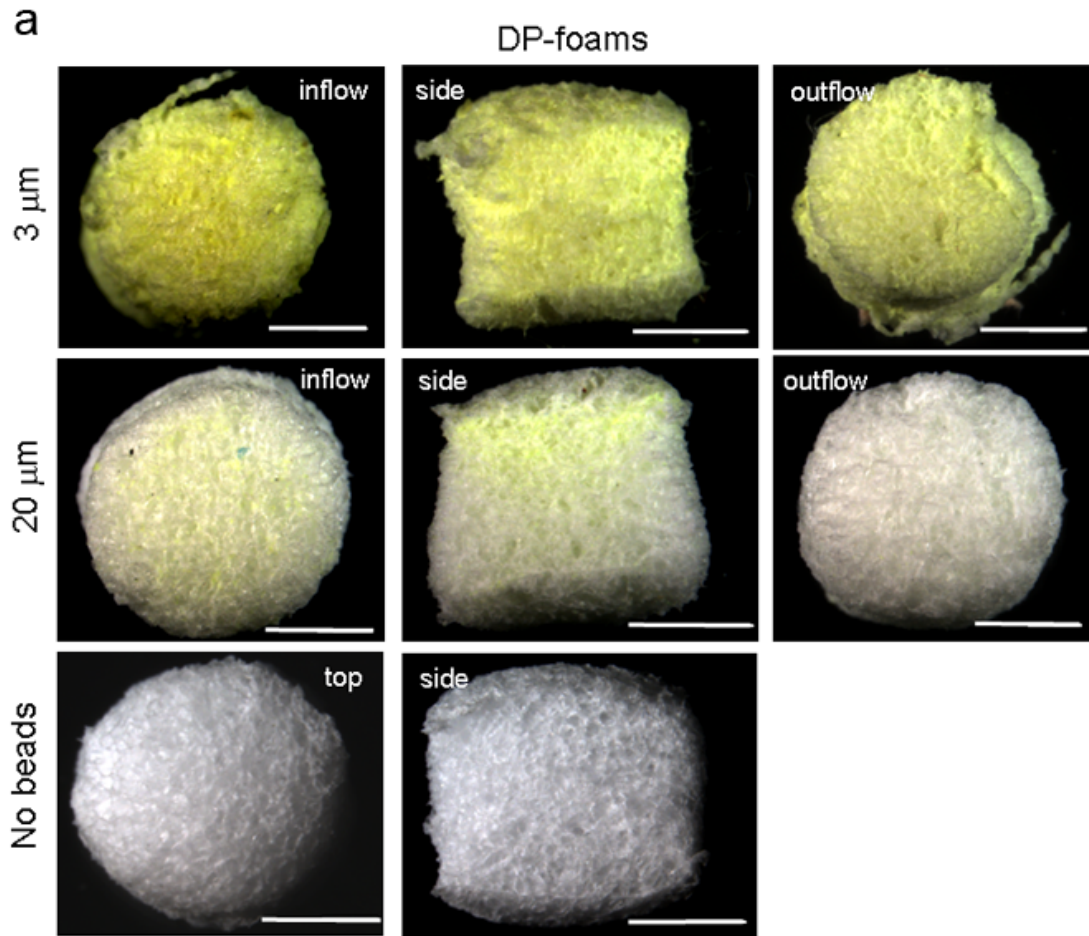
Figure 4. Perfusion of DP-, PU- and PVA-foams with BSA-pre-adsorbed and differentially-sized